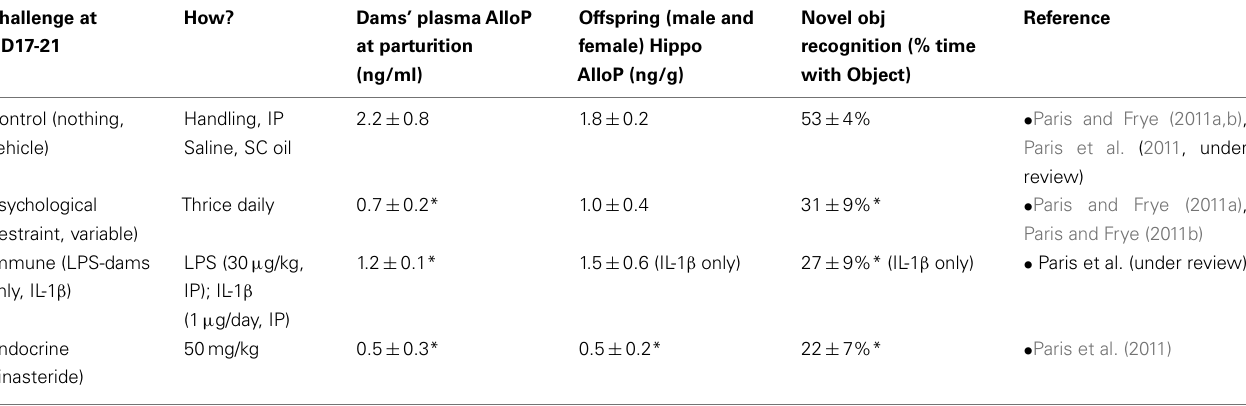
Table 1 | Summarized results (mean ± SEM) adapted from recent prenatal stress (PNS) studies in our lab, which indicate the effects of PNS via psychological stress [exposure to physical restraint (restraint) or unpredictable variable stress (variable) which included forced swim, restraint, cold exposure, overnight fasting, light, and social crowding], immune challenge [exposure to lipopolysaccharide (LPS, 30 μ g/kg; dams only), or interleukin-1 β (IL-1 β , 1 μ g/rat)], finasteride administration (50mg/kg), or minimal handling/vehicle (control) on gestational days 17–21 ( n = 4–8 dams/group; n = 17–30 offspring/group) has on maternal/fetal allopregnanolone and dependent cognitive behaviors (object recognition performance) of male and female rats (data are collapsed on the variable of